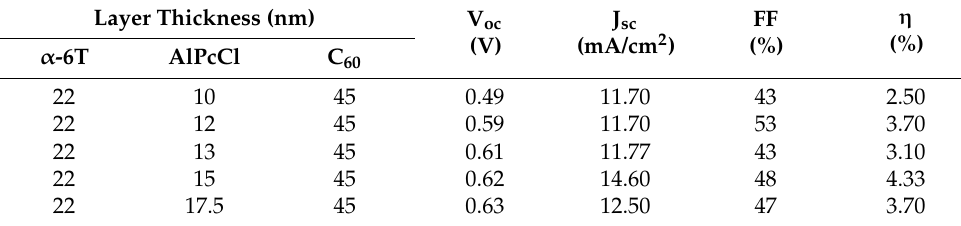
Table 1. Parameters of the ternary PHJ-OPVs based on the active layer: 6T/AlPcCl/C 60 . Layer Thickness